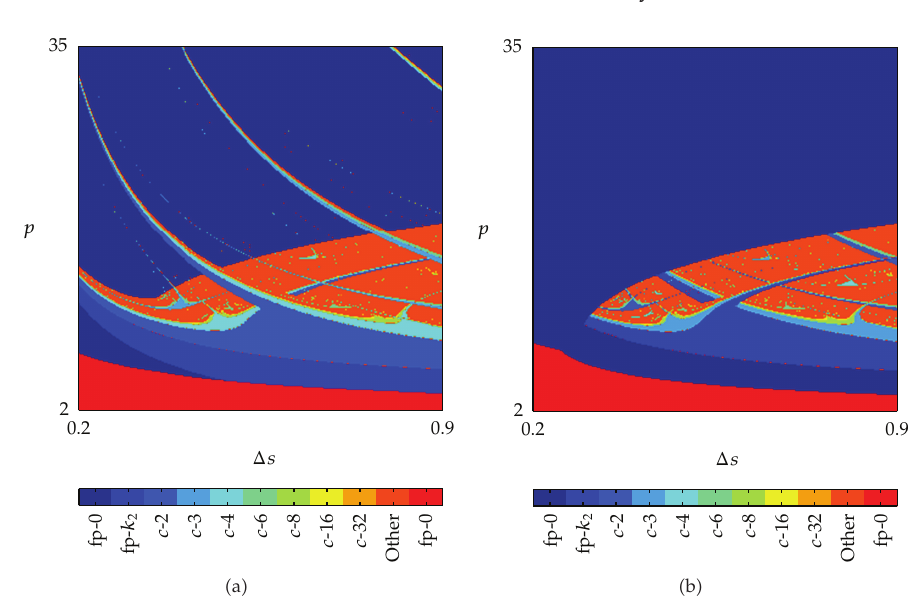
Figure 8: Two dimensional bifurcation diagrams of map F in the plain (cid:3)Δ s,p (cid:6) for the following parameter values: δ (cid:7) 0 . 2, α (cid:7) 1, β (cid:7) 0 . 9, n (cid:7) 0 . 5, s w (cid:7) 0 . 1; (cid:3) a (cid:6) the initial condition is k M ; (cid:3) b (cid:6) the initial condition is k m .